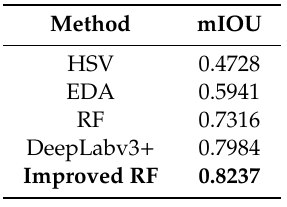
Table 4. mIOU scores for di ff erent methods applied to the training or validation dataset.